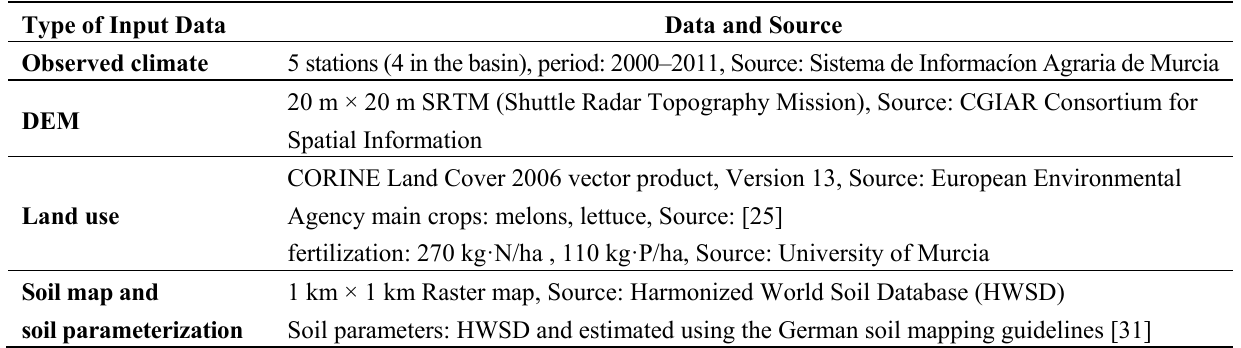
Table 1. Overview of spatial and temporal input data used to set up the SWIM